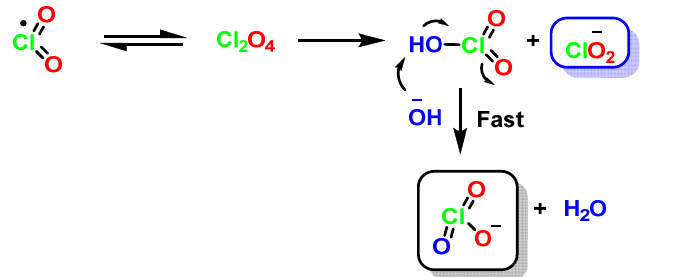
Figure 10. Mechanism of formation of ClO 2 − from ClO 2 in basic medium. Figure 11. Mechanism of the formation of equimolar amounts of ClO 2 − and ClO 3 − from Cl 2 O 4 in basic medium.